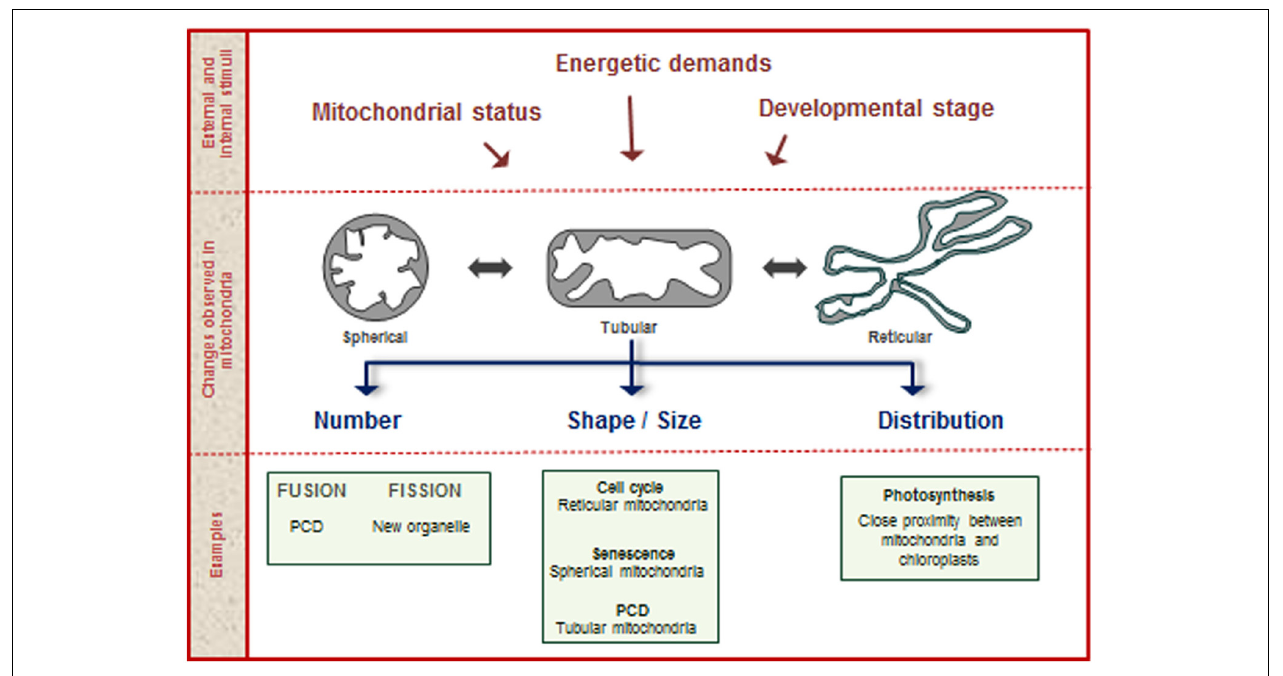
FIGURE 1 | Mitochondrial dynamics. During the plant life cycle, mitochondria change in shape, size, and number, according to numerous stimuli provided by internal and external factors. Examples of processes related with changes in mitochondrial structure are shown in the lower part of the figure.